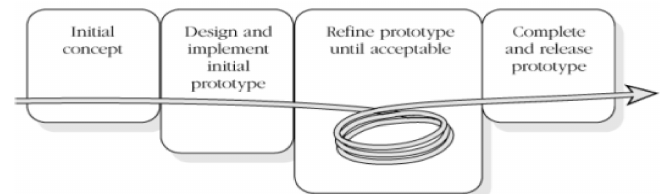
Fig. 3 Evolutionary Prototyping (EP) framework for ABI prototype development [47]